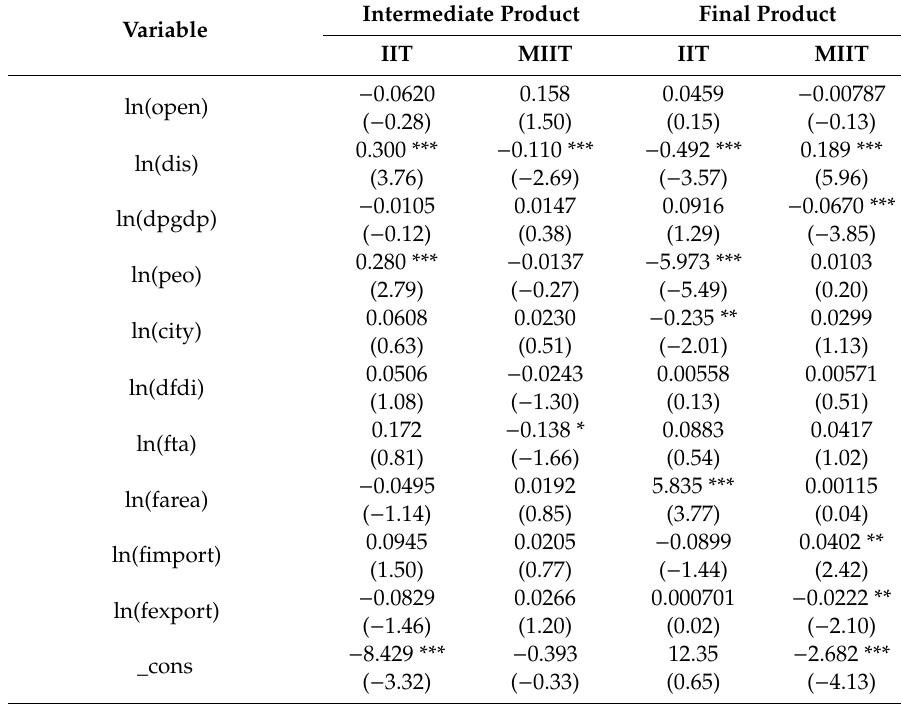
Table 7. Model robustness test